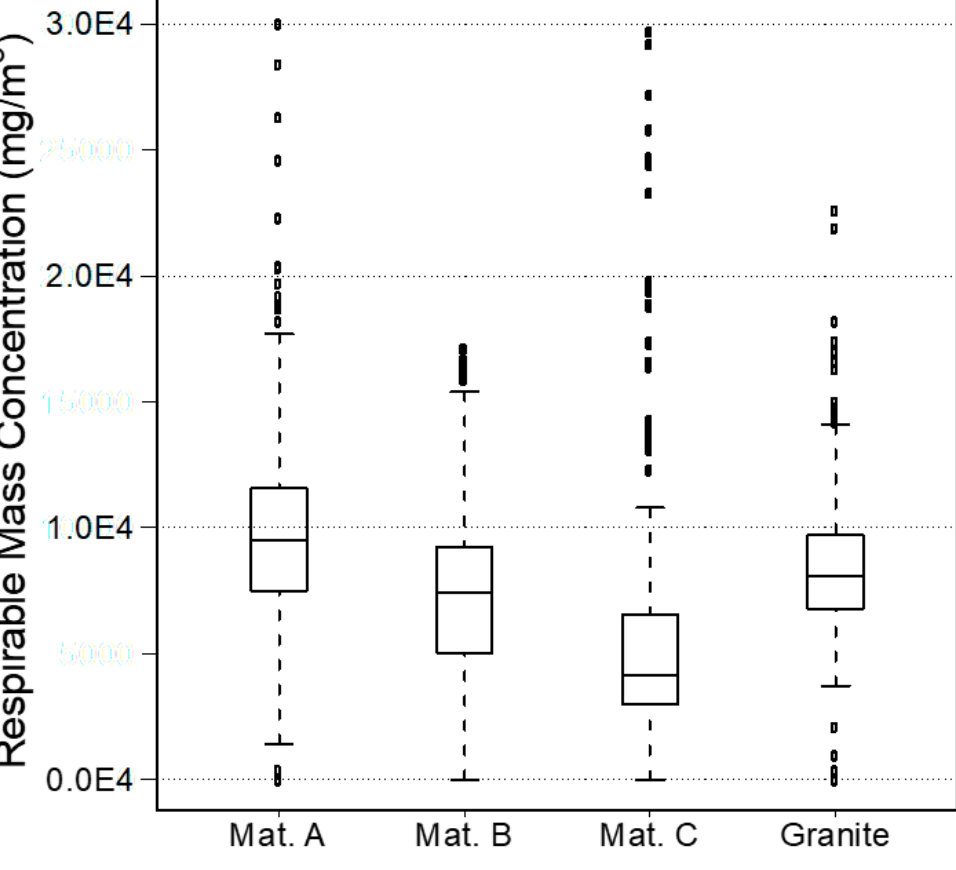
Figure 2. Boxplots of respirable mass concentrations by material.